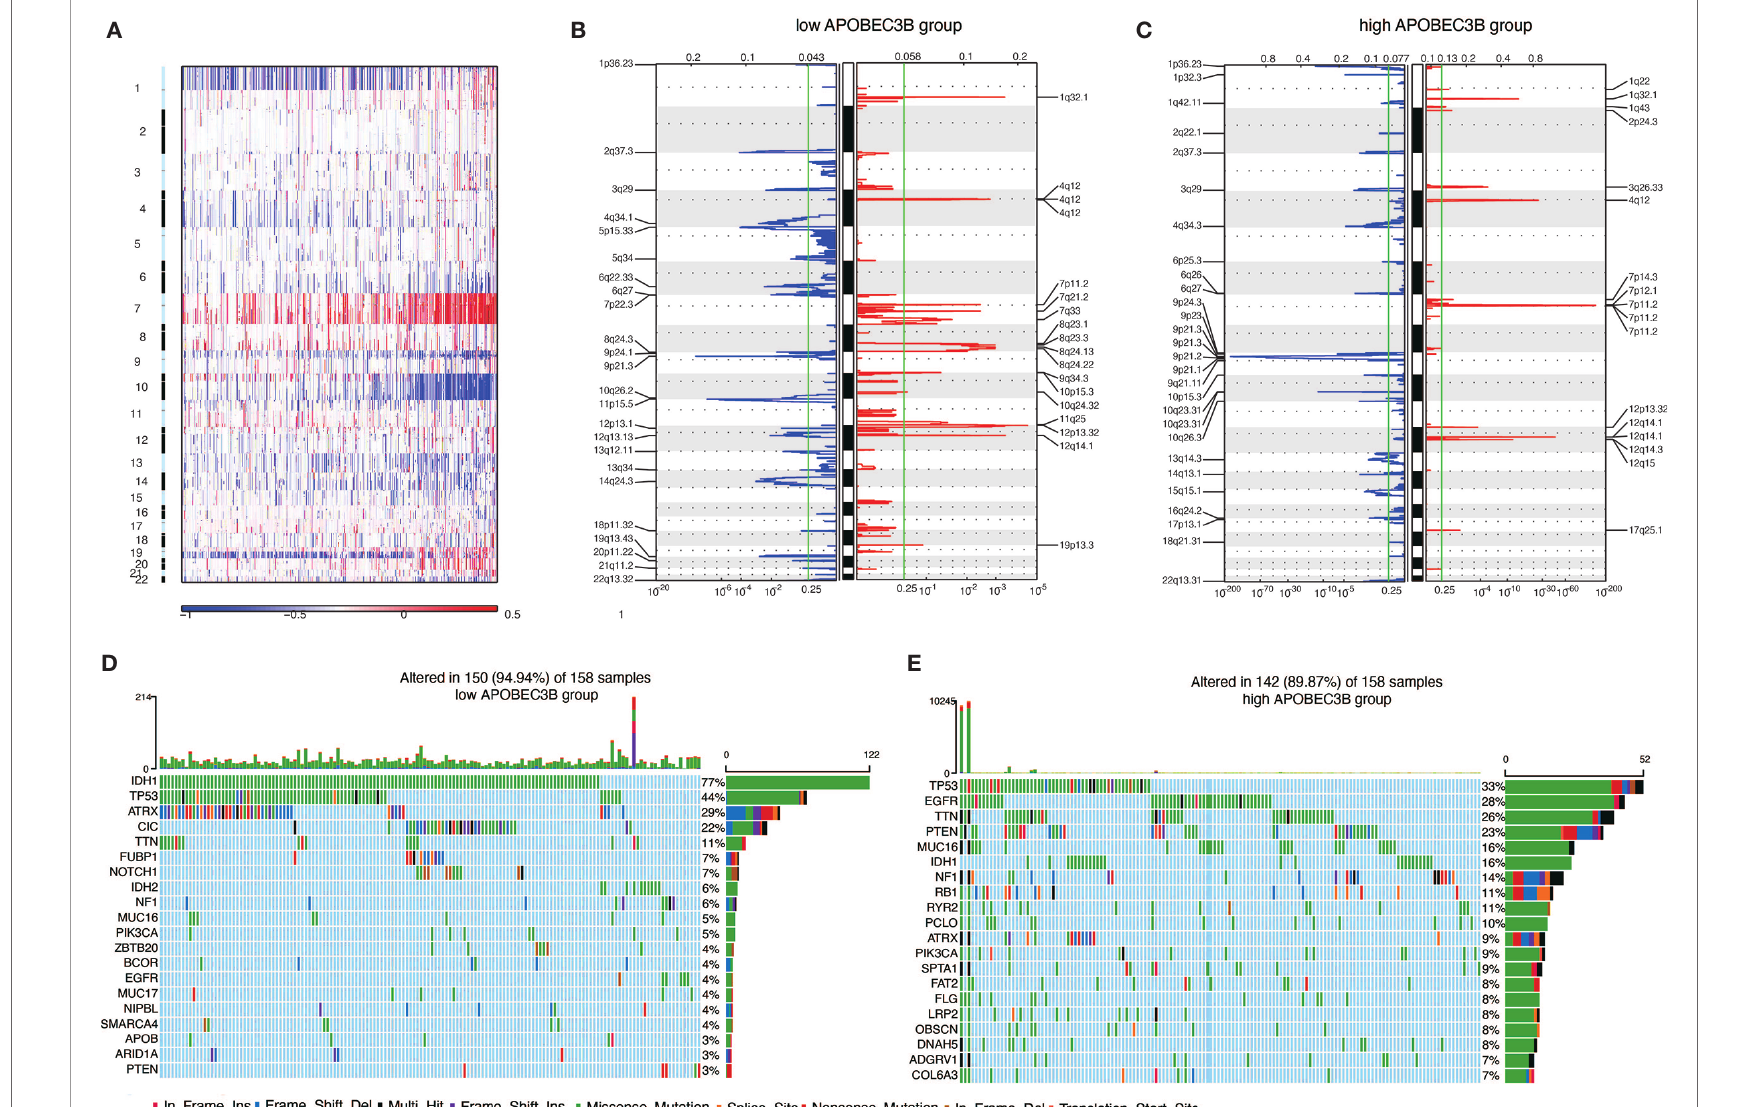
FIGURE 4 | APOBEC3B expression is related to genomic alterations in glioma. (A) Overall CNV pro fi le according to high vs low APOBEC3B expression. Blue (deletion); Red (ampli fi cation). Frequency of speci fi c changes based on (B) APOBEC3B low and (C) APOBEC3B high groups. The X-axis represents the frequency of chromosomal deletion (blue) or ampli fi cation (red). Spectrum of somatic mutations in gliomas from (D) APOBEC3B low and (E) APOBEC3B high